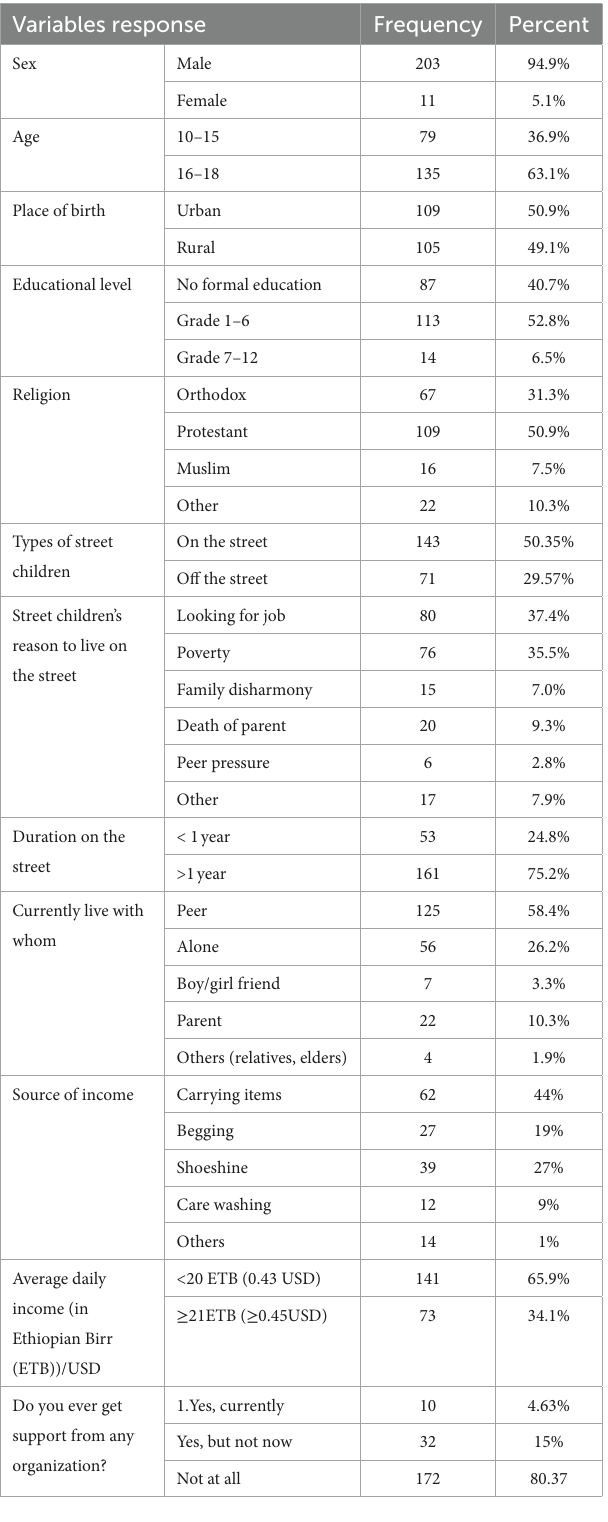
TABLE 1 Socio-demographic and economic characteristics of street children in Wonago town, Southern Ethiopia, 2021. Variables response